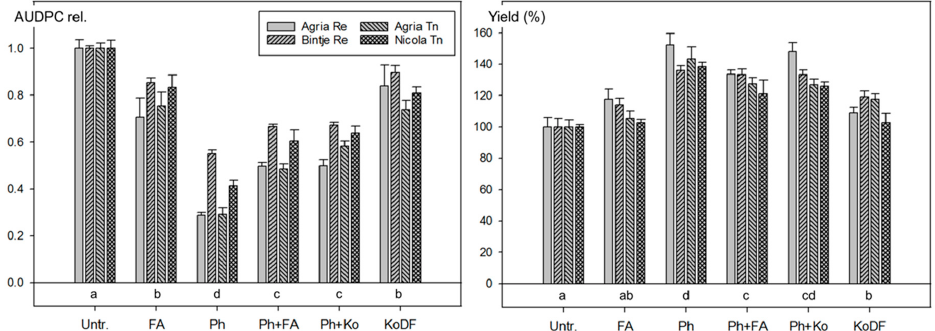
Figure 4. Field experiments in 2012 at Reckenholz (Re) with the potato varieties Agria and Bintje and at Tänikon (Tn) with Agria and Nicola: Effect of Frangula alnus (FA), Phosfik ® (Ph), Ph followed by FA (Ph+FA) or Kocide DF applications (Ph+Ko) and of Kocide DF (KoDF) on foliar blight (AUDPC) and on yield. Treatments are described in Table S4. Untr. = Untreated control. Bars: Mean values of the varieties and standard errors of the means. AUDPC rel.: Area under the disease progress curve relative to the untreated control. Treatments labelled with the same letter are statistically not different (Tukey test p < 0.05).